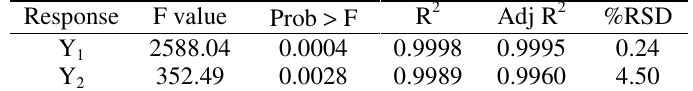
Table 4 . Summary of ANOVA for the response parameters of the model mobile